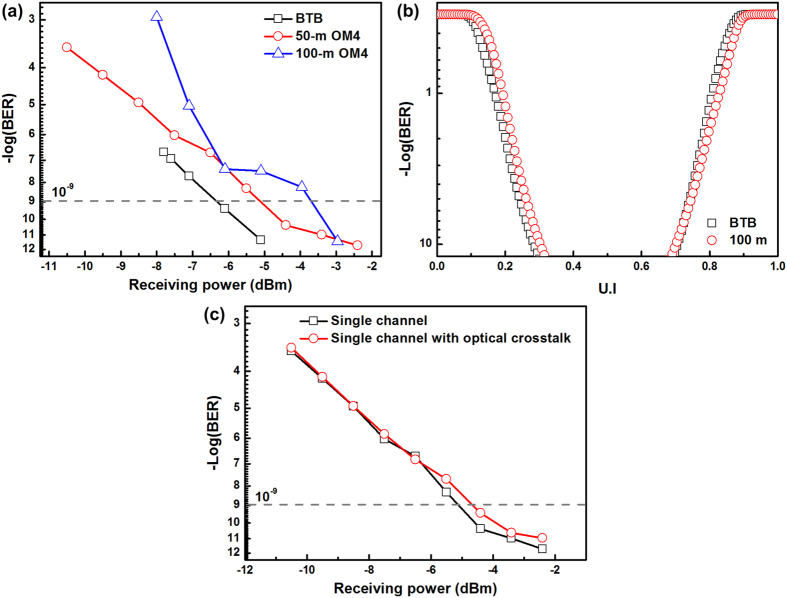
The transmission performances of temperature-stabilized 400-Gbps CDFP optical transceiver.(a) The measured BERs after BTB, 50-, and 100-m OM4 MMF transmissions; (b) The bathtub curves under BTB and 100-m OM4 MMF transmissions; (c) The optical crosstalk measurement.